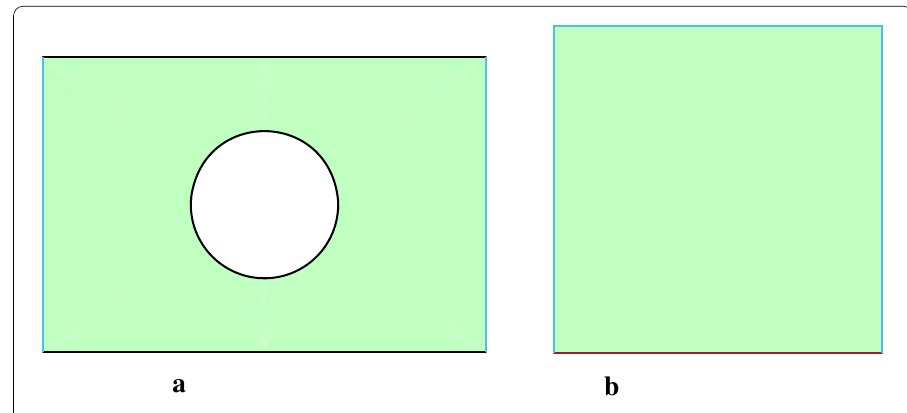
a b Fig. 5 Geometries in the two model problems. Boundaries with non-homogeneous Neumann conditions are indicated in blue and Dirichlet boundaries are indicated in red. a Neumann problem. b Manufactured